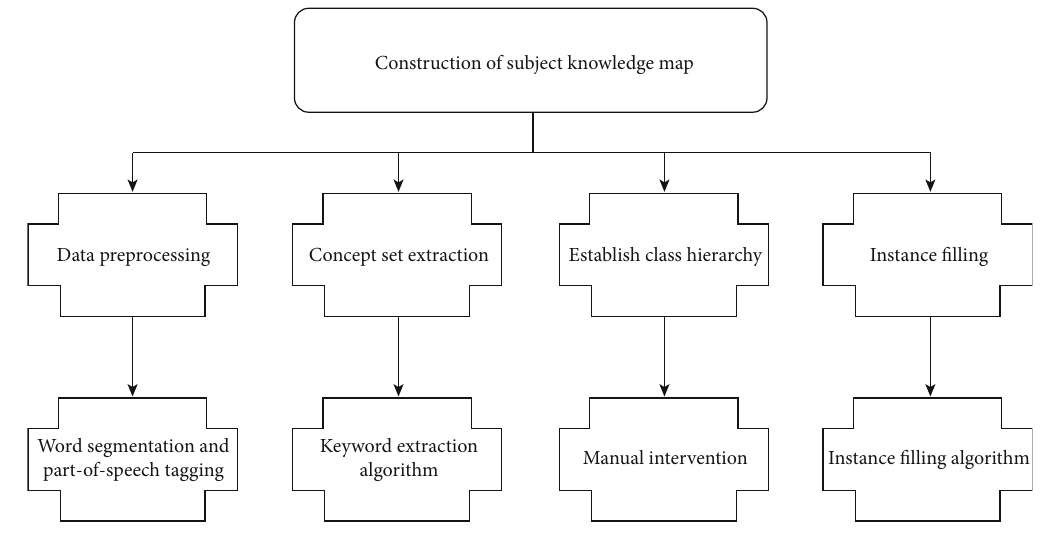
Figure 1: Framework of discipline knowledge map